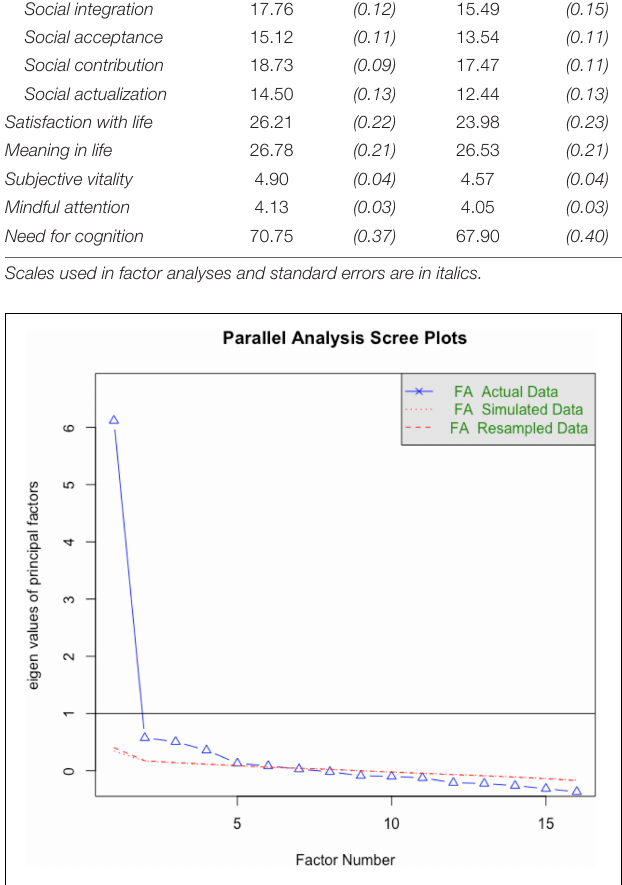
FIGURE 2 | Parallel analysis scree